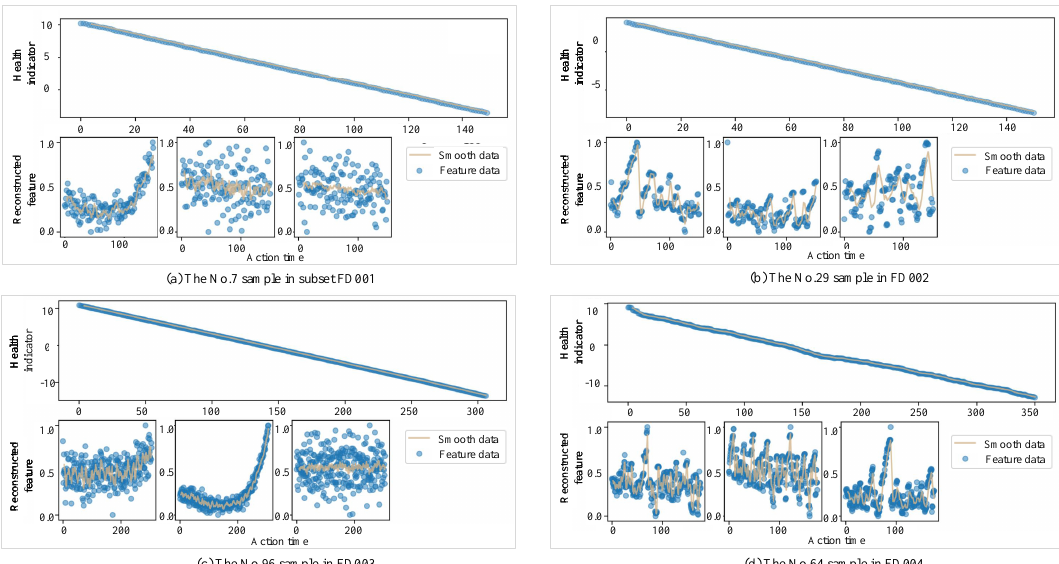
Figure 7. The comparison of health indicator and three representative reconstructed features of four samples from each sub dataset. ( a ) The comparison of the health indicator and three representative reconstructed features of the sample number 7 in subset FD001. ( b ) The same comparison with the sample number 29 in subset FD002. ( c ) The same comparison with the sample number 96 in subset FD003. ( d ) The same comparison with the sample number 64 in subset FD004. The trend of data is shown more clearly by smoothing data.